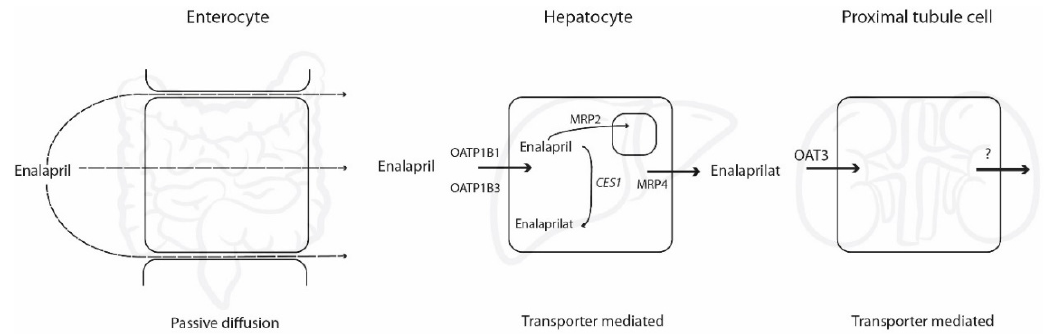
Figure 1. Processes governing absorption, metabolism, and excretion of enalapril and enalaprilat in the intestine, liver, and kidney. CES1: carboxylesterase 1.